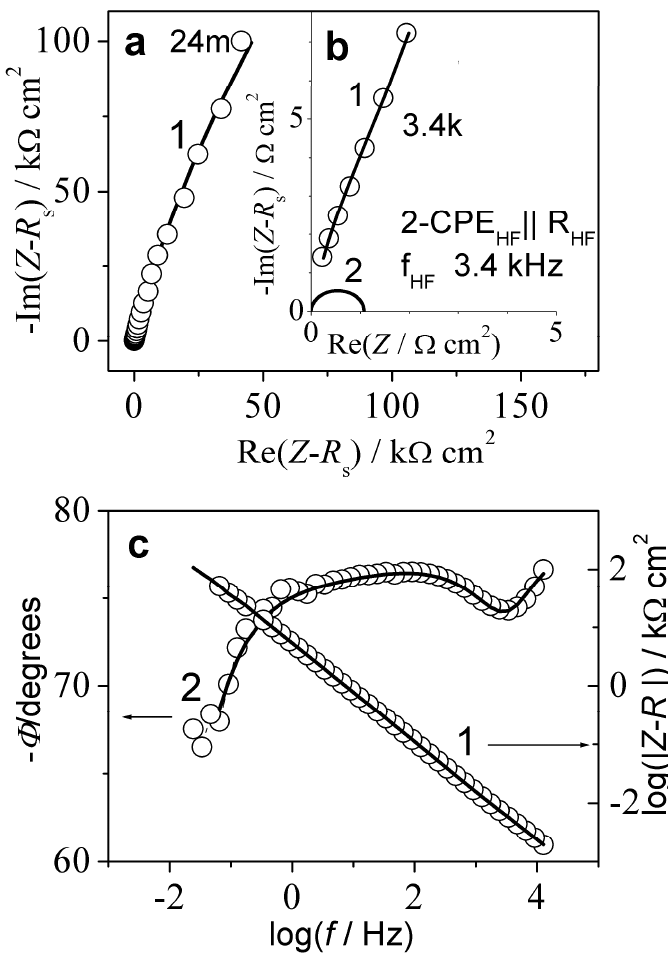
Fig. 8 Measured and calculated (according to the EC model of Fig. 9b.) impedance diagrams determined at the corrosion potential E corr = –0.312 V of the electrodeposited sample B after 18 h wet immersion and 18 h atmospheric corrosion followed the SWPC treatment: (a) in complex plane 1-o- measured, solid line- fitted data; inset (b) 1 – HF part and 2 – calculated HF CPE || R sub-circuit of EC model on Fig. 9b; (c) the corresponding Bode plots 1, 2-o- measured, solid lines- fitted data, 1 – original data, 2 – 1 data set with subtraction of solution